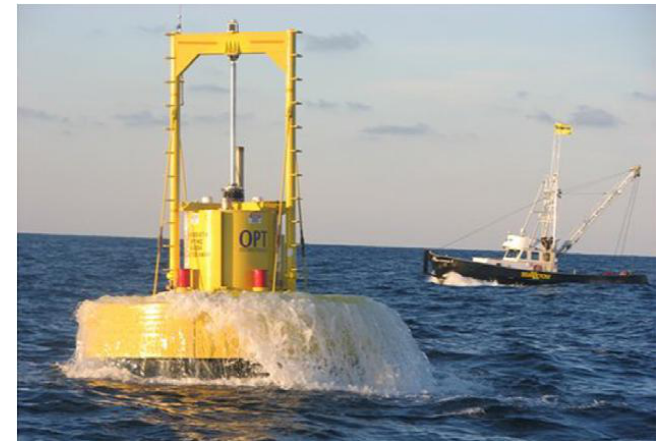
Figure 2. The PowerBuoy WEC oscillating in the sea [49] .